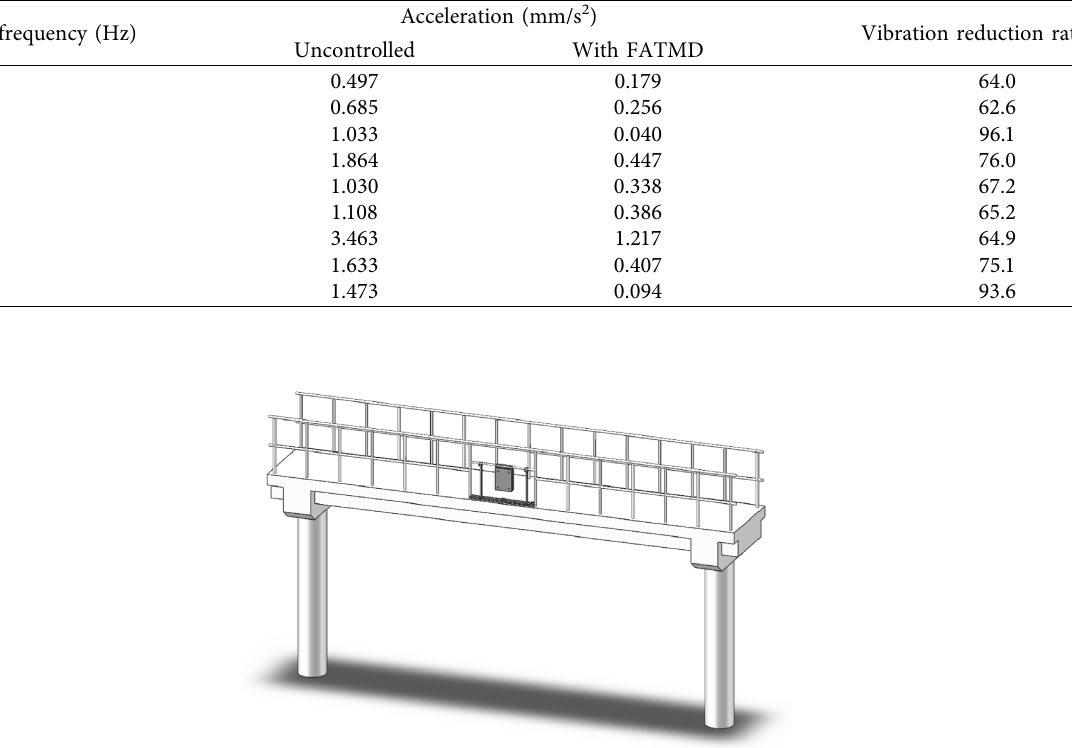
Figure 11: Schematic of a pedestrian bridge installed with an